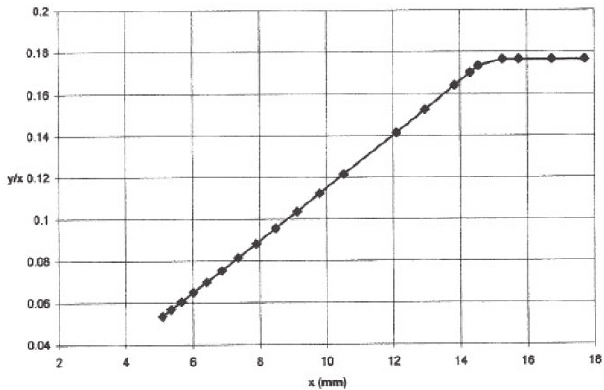
Figure 5A: The position of the needle (tracking the TN-point, equiv- alent to point 12 in Fig. 1) during the VP action for an initial shallow injection angle situation, where θ 0 = 10 ◦ and length of the needle is 18 mm.